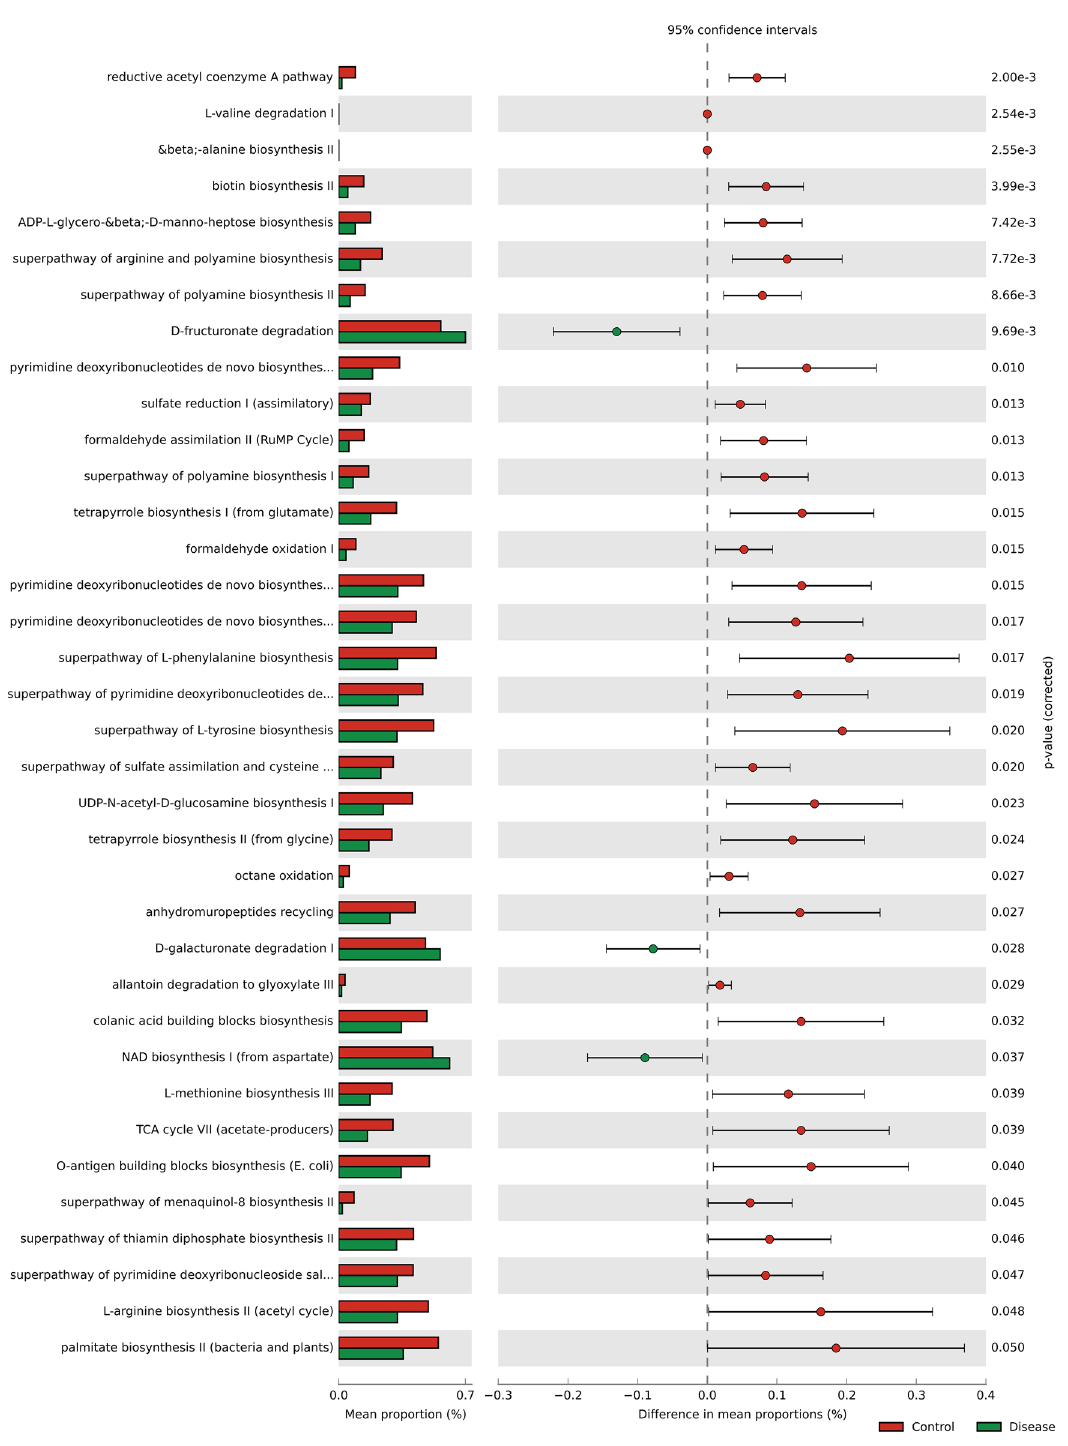
Figure 6. Predicted differential KEGG pathways in HC and Anti-IFN-γ AAbs. The extended error bar plot of significantly differential KEGG pathways was predicted using PICRUSt2 analysis. Bar plots on the left side display the mean proportion of each KEGG pathway. Dot plots on the right show the differences in mean proportions between the two indicated groups using p value. Only p value < 0.05 (Welch’s test) are shown. anti- IFN-γ AAbs anti-interferon-gamma autoantibodies, HC healthy